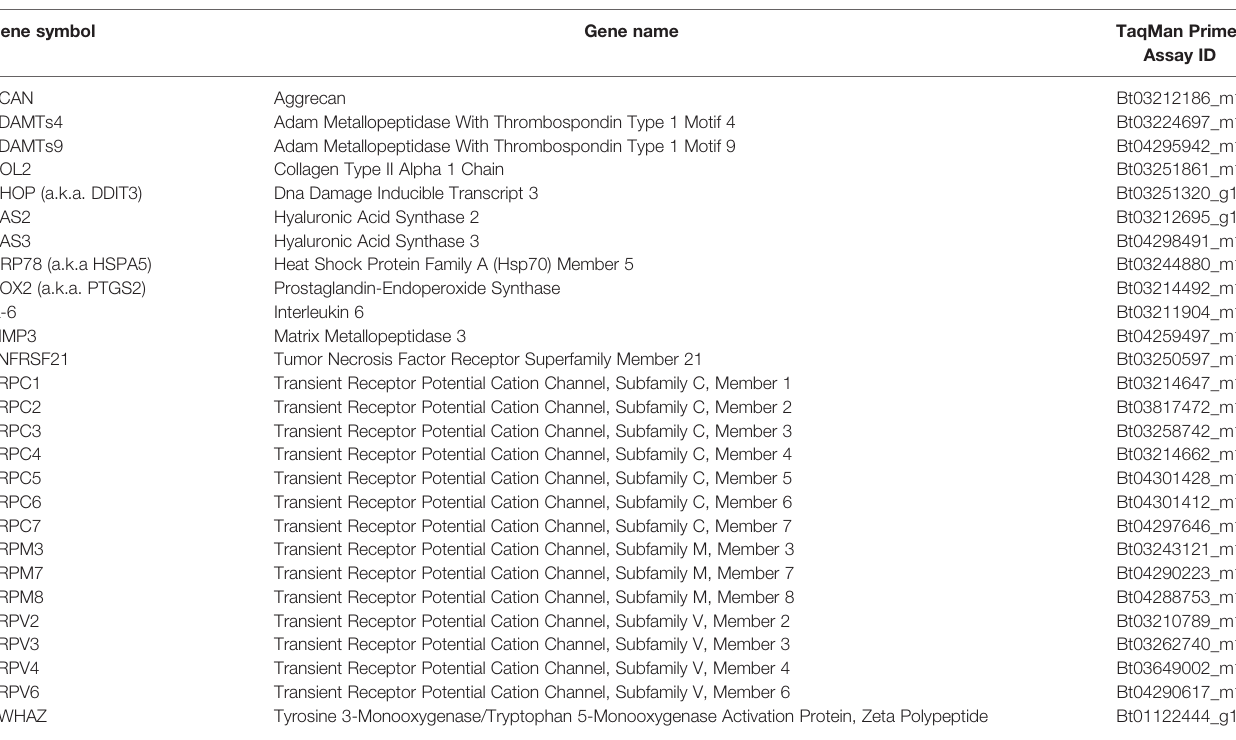
TABLE 2 | TaqMan primers